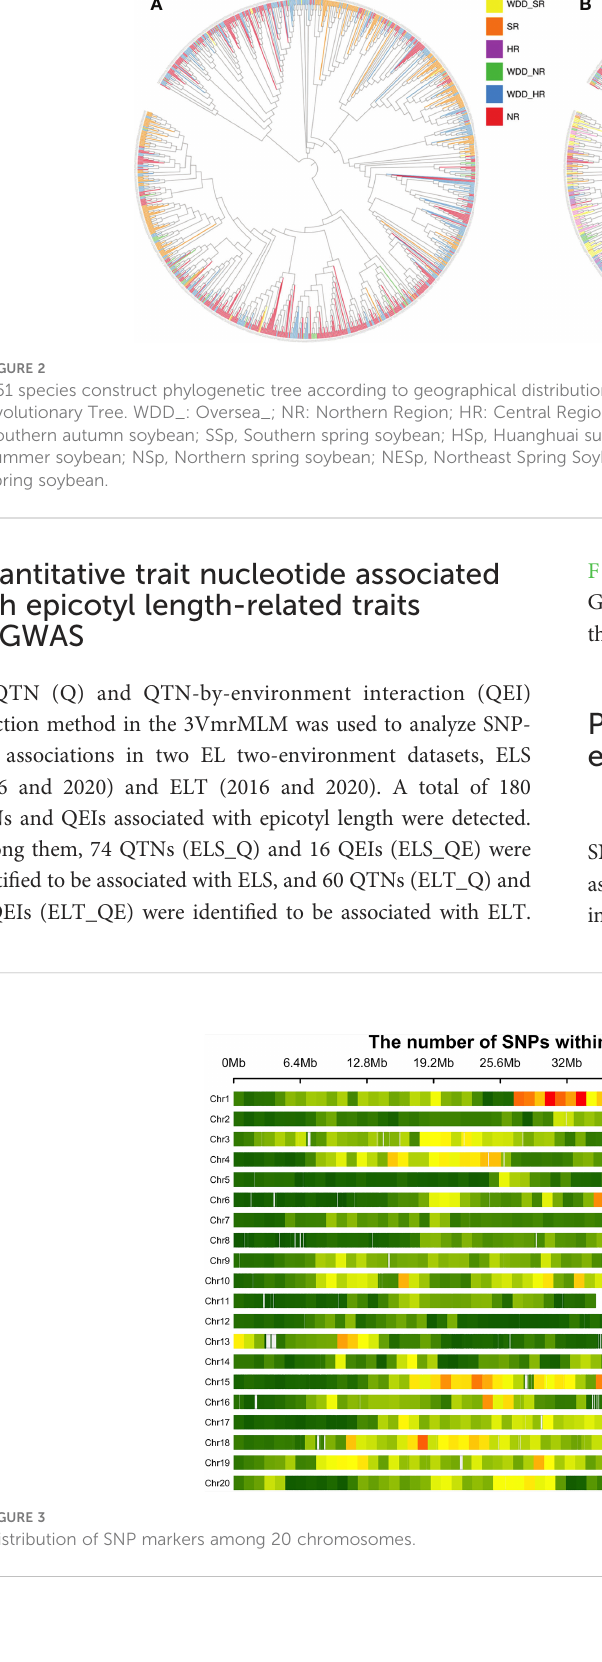
FIGURE 3 Distribution of SNP markers among 20 chromosomes.